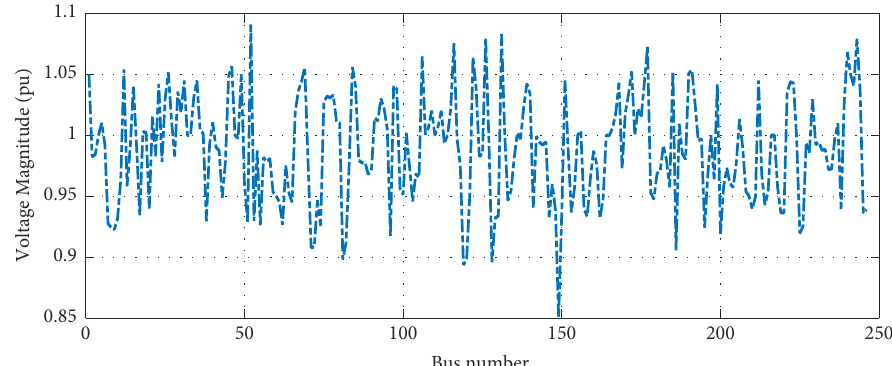
Figure 9: Voltage magnitude before STATCOM is connected.